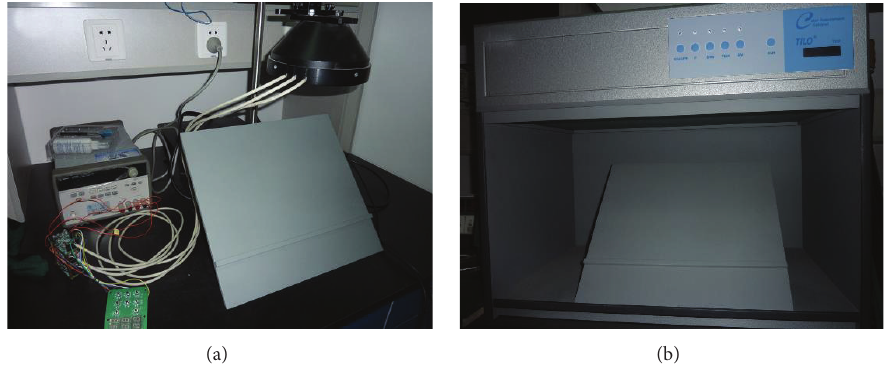
Figure 2: Color vision system calibration results: (a) the artificial D65 illuminator and (b) the scene of calibration for color vision system.